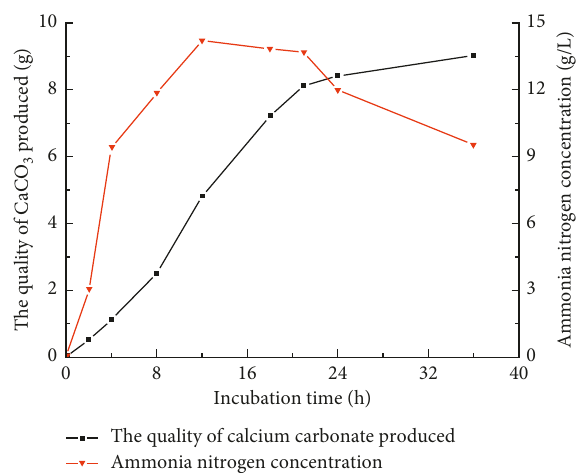
Figure 9: The changes in ammonia nitrogen concentration and CaCO 3 production as function of